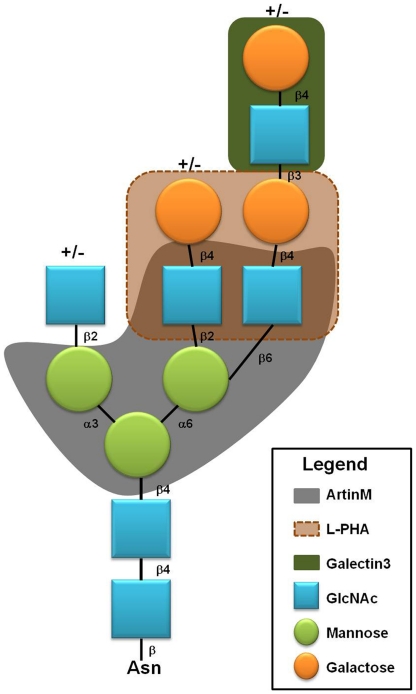
β1-6GlcNAc branched N-glycan is targeted by three different lectins.The targeted areas by ArtinM (grey), L-PHA (brown) and galectin-3 (green) are highlighted in the figure. ArtinM binds to Manα1-3(Manα1-6)Manβ-R core and posses a sub domain that establishes additional interaction with GlcNAc in the context of α1-6Mannose branch. L-PHA binds to the sequence Galβ1-4GlcNAcβ1-2(Galβ1-4GlcNAcβ1-6)Manα-R, which partially merges with the area targeted by ArtinM. Galectin-3 binds to distal poly-N-acetyllactosamines, which does not merge with the areas targeted by ArtinM or L-PHA.